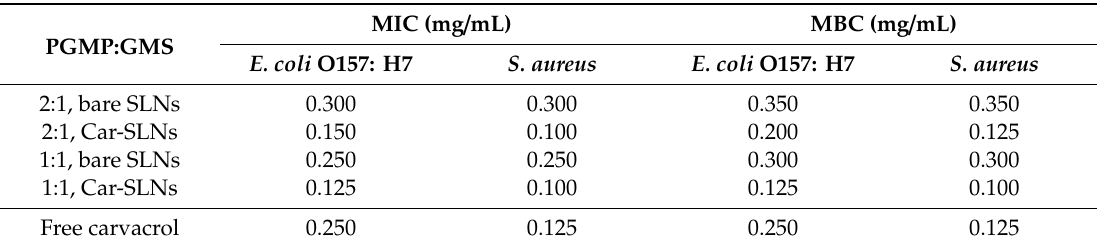
Table 4. Antimicrobial activities of Car-SLNs with a carvacrol loading at 30% mass of lipids, free carvacrol, and two bare